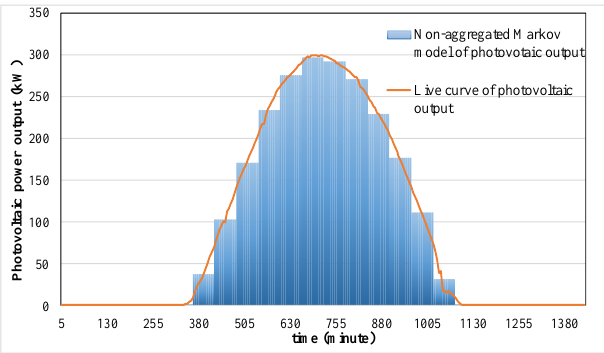
Figure 6. The actual power curve and non-aggregate Markov model of photovoltaic power output.